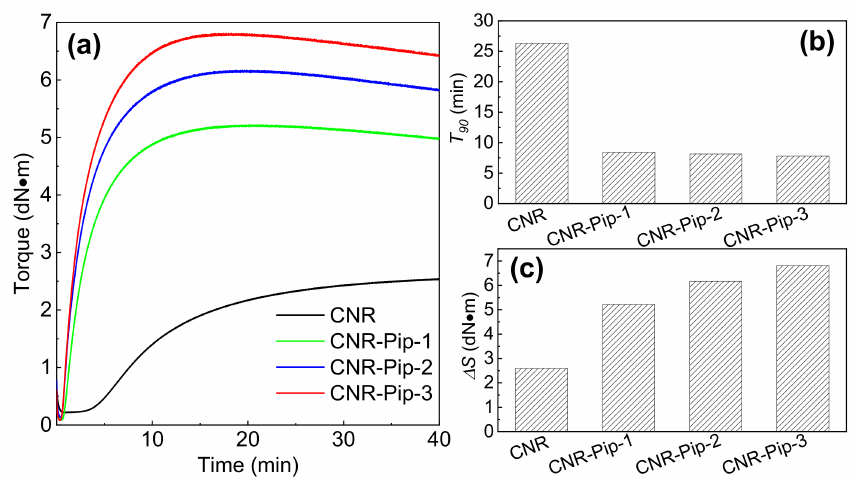
Figure 2. Changes in vulcanization process after the addition of phase transfer agent. ( a ) Vulcan- ization curves of CNR, CNR-Pip-1, CNR-Pip-2, and CNR-Pip-3. ( b ) T 90 comparison among CNR, CNR-Pip-1, CNR-Pip-2, and CNR-Pip-3. ( c ) ∆ S comparison among CNR, CNR-Pip-1, CNR-Pip-2, and